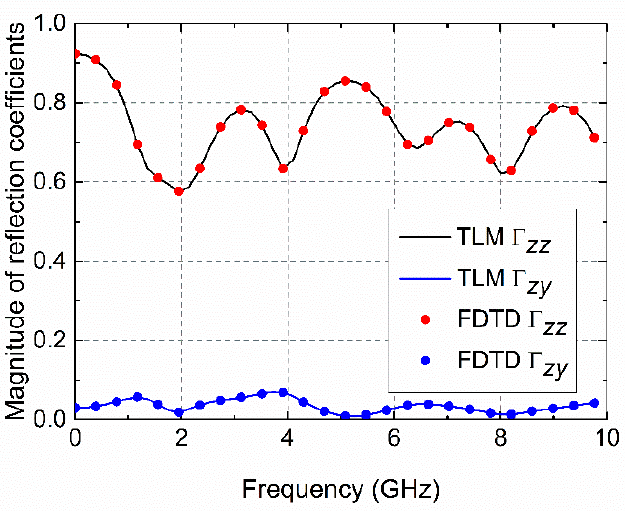
Figure 9. Magnitude of the reflection coefficients versus frequency for a three-layered carbon-fiber material.